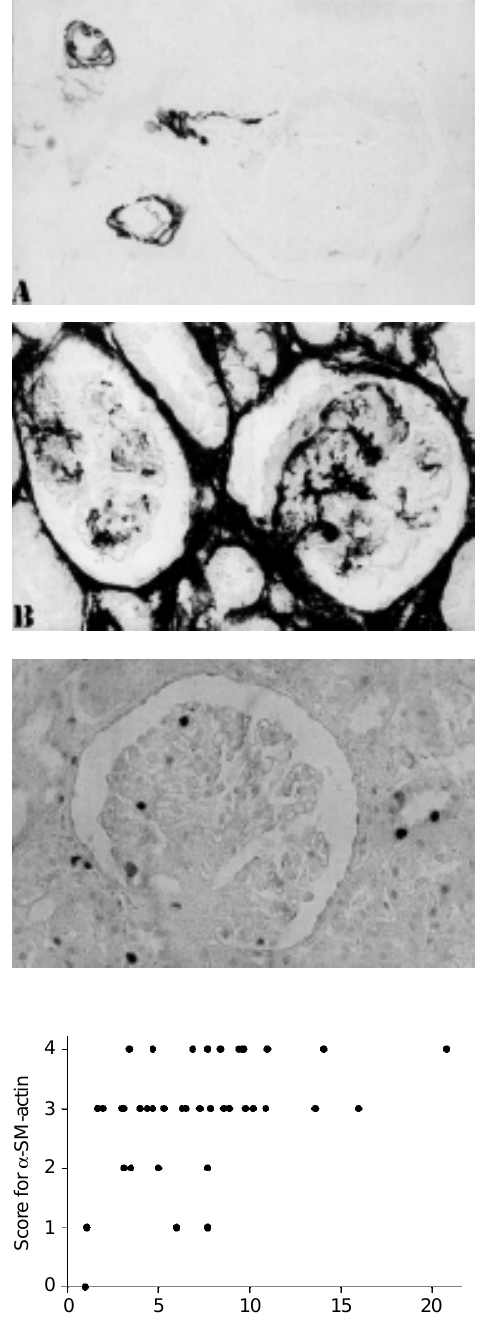
Figure 5. Correlation between a -smooth muscle actin ( a -SM- actin) score in the tubulointer- stitial area from the renal cortex and proteinuria at the time of biopsy (r = 0.363, P =